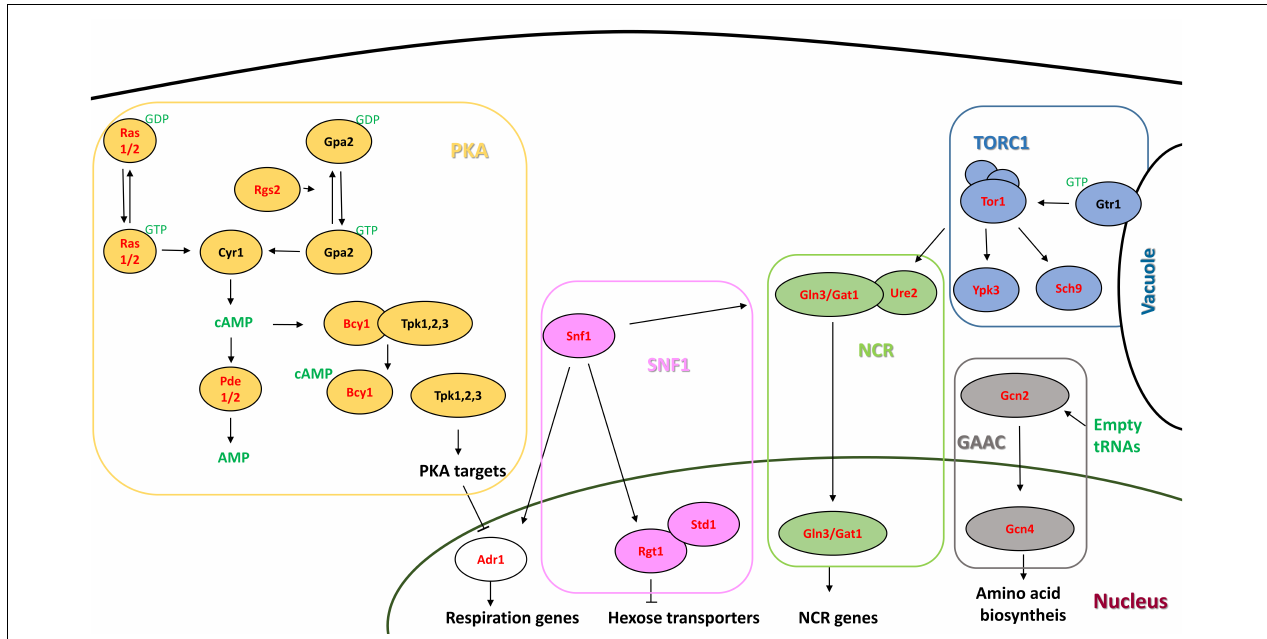
FIGURE 1 | Schematic depiction of the main nutrient signaling pathways in S. cerevisiae . The proteins tested by deletion are indicated in red. Signaling molecules are indicated in